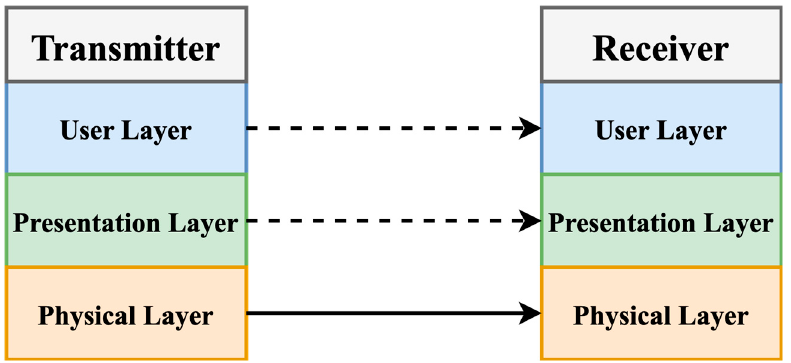
Figure 3. Communication protocol stack.